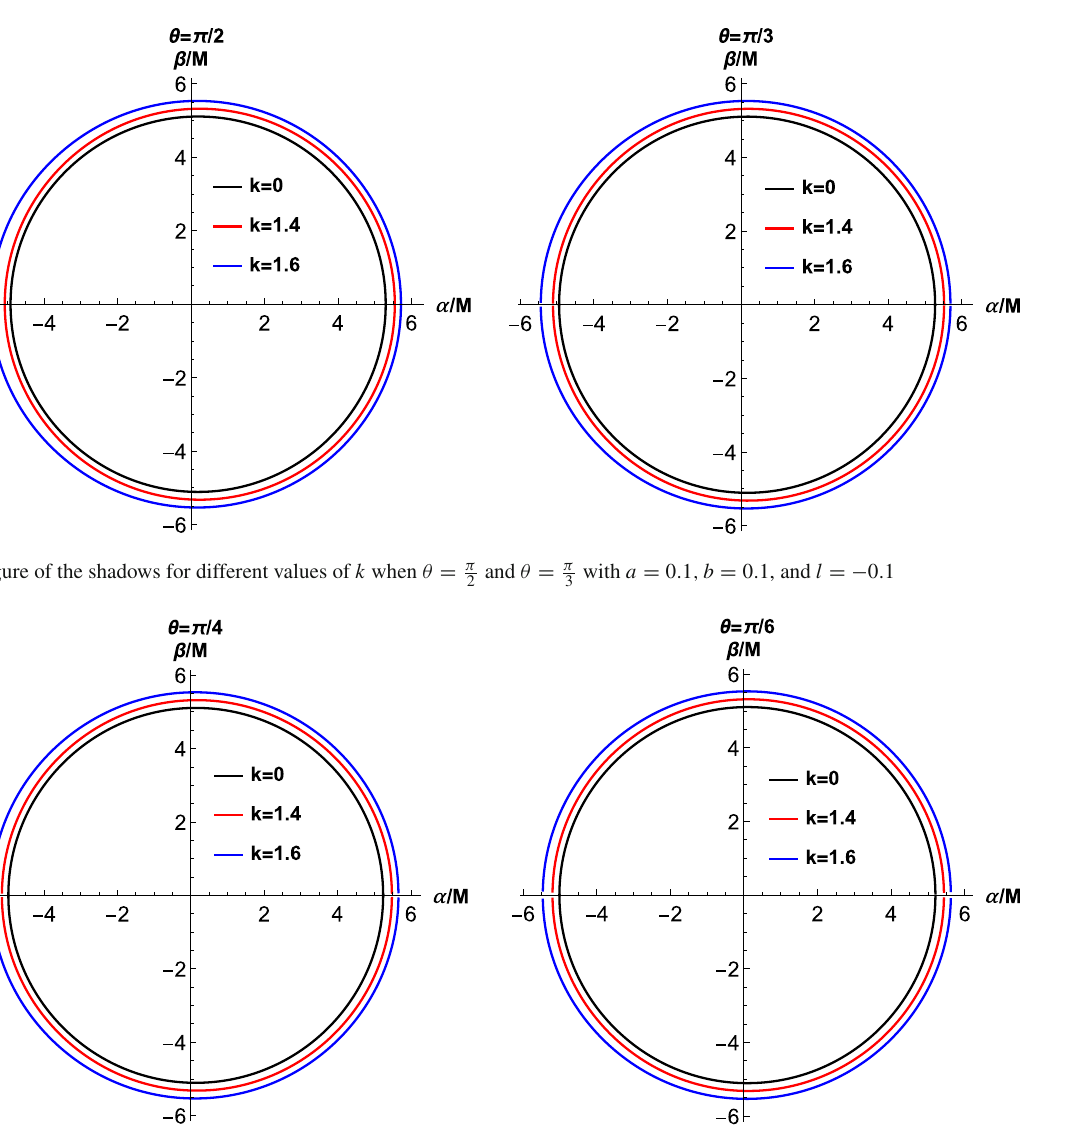
Fig. 6 The figure of the shadows for different values of k when θ = π